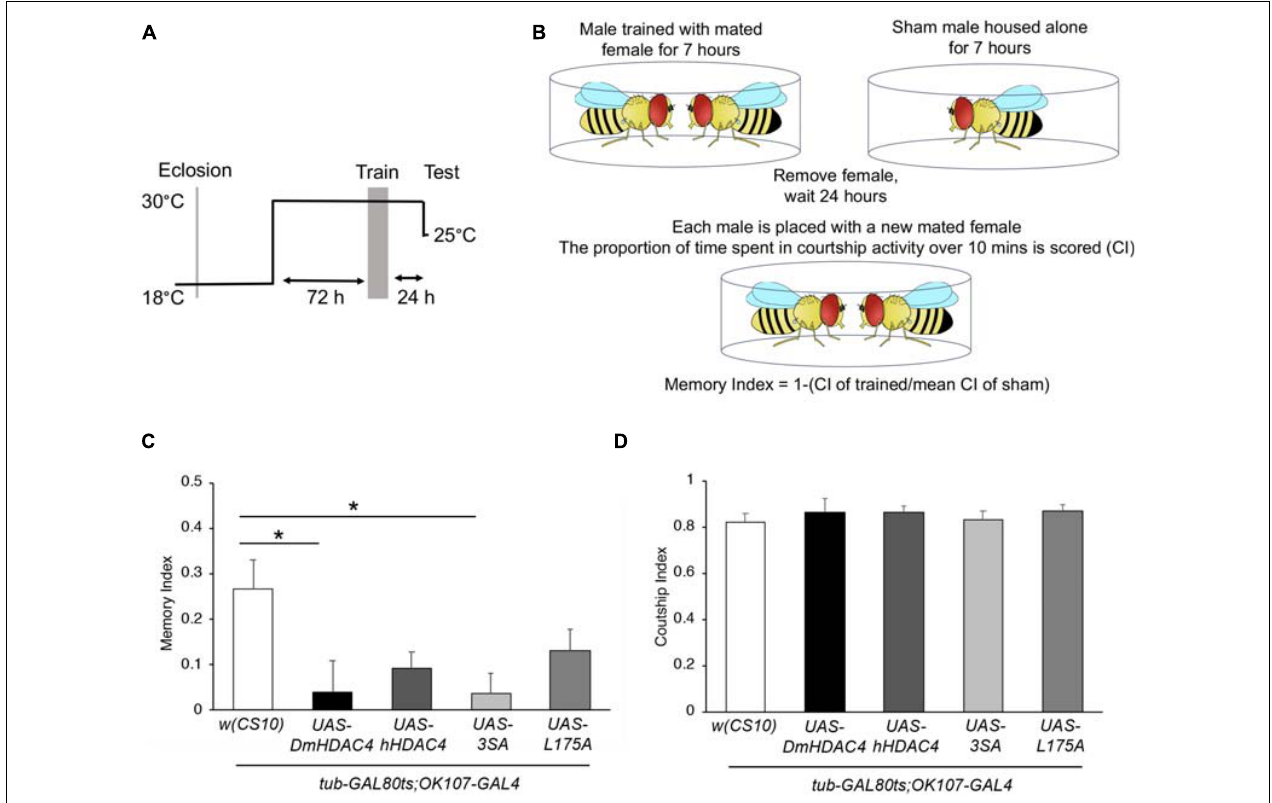
FIGURE 4 | Nuclear accumulation of HDAC4 disrupts long-term memory. (A) Schematic diagram describing the protocol for induction of expression in the adult mushroom body. All genotypes were generated by crossing OK107-GAL4; tubP-GAL80 ts females to males carrying the indicated UAS-transgene or to the w(CS10) control (CS). Flies were raised at 18 ◦ C until after eclosion, then placed at 30 ◦ C. They were trained 72 h later and remained at 30 ◦ C until 1 h prior to testing at which time they were equilibrated to the testing temperature of 25 ◦ C. (B) Schematic diagram describing the courtship suppression assay. (C) 24-h courtship LTM was significantly impaired by expression of DmHDAC4 and 3SA in the adult brain [ANOVA, F ( 4 , 209 ) = 3.59, p < 0.007; post-hoc Tukey’s HSD, * p < 0.05]. (D) Courtship activity was not altered by expression of any of the HDAC4 variants [ANOVA, F ( 4 , 214 ) = 0.45, p =